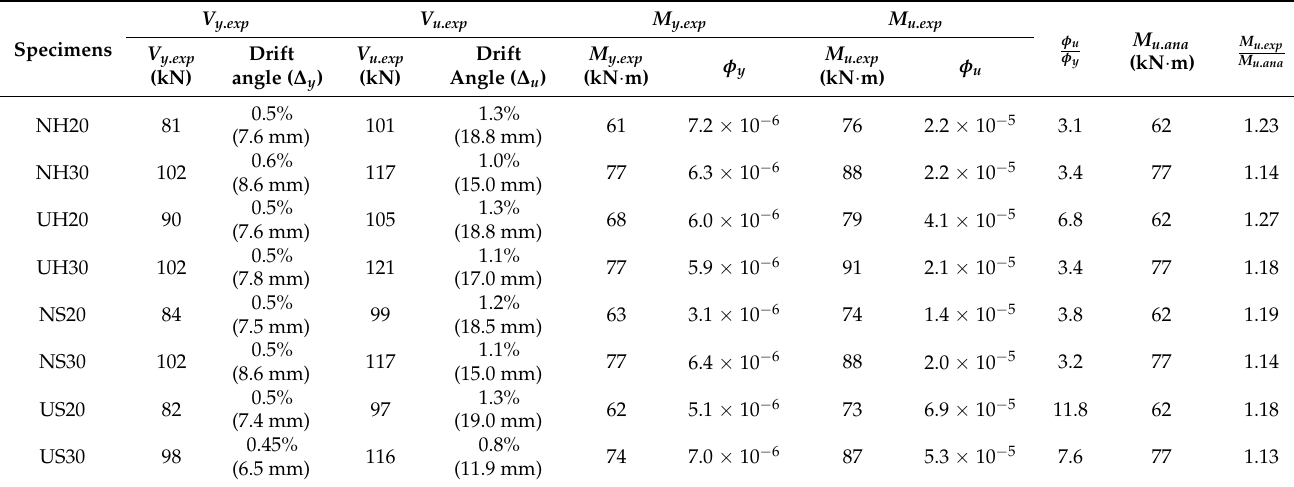
Table 2. Test results (1 kN = 4.45 kips, 1 MPa = 145 psi, 1 mm = 0.0394 in).